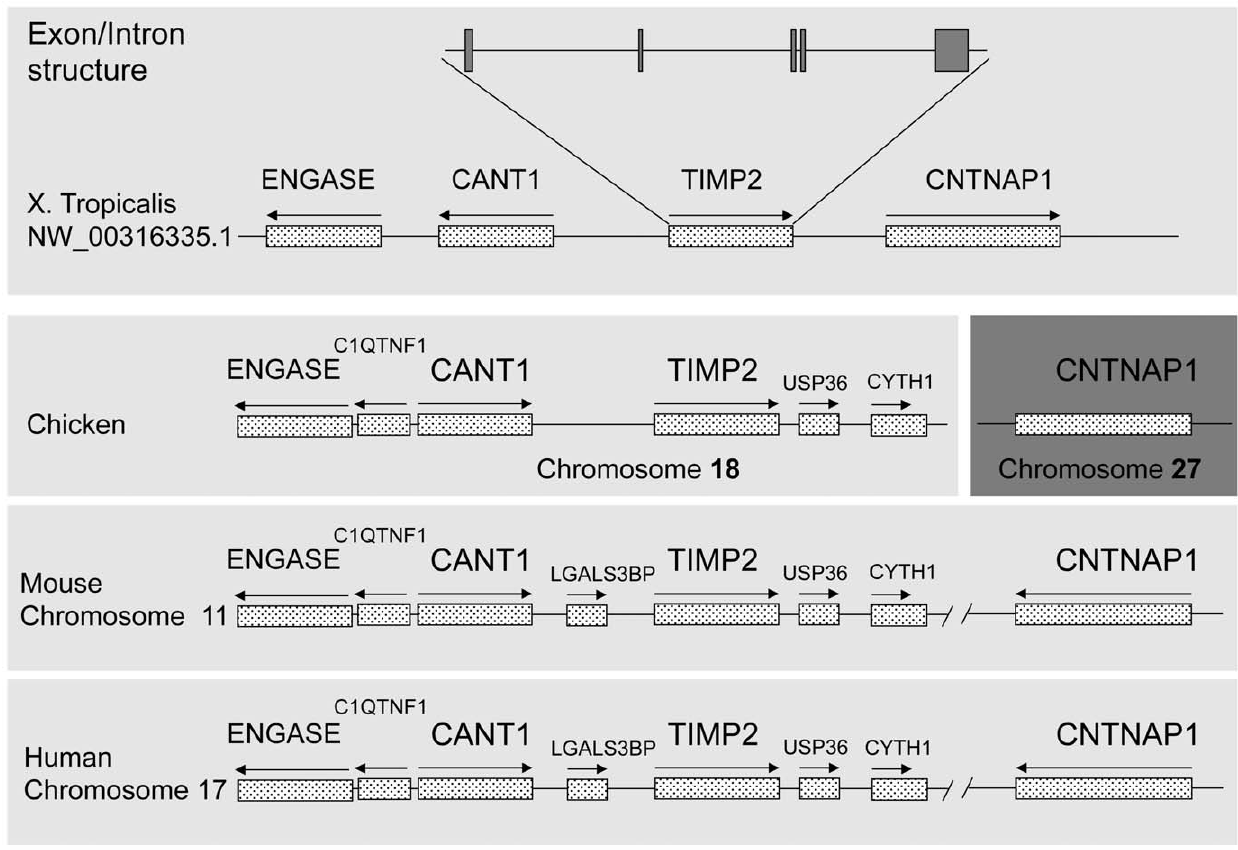
Figure 2. Comparison of the genomic locus and organization of X.tropicalis and human TIMP2. X. tropicalis, chicken, mouse and human TIMP2 genomic organizations were obtained from NCBI database. The lines represent the genomic sequences and the boxes with arrowed lines on top represent transcribed regions and the direction of the transcription. The lines and boxes were not drawn to the same scale for better visualization. The TIMP2 gene in all four species has the same intron/exon organization with 5 exons total as shown for X. tropicalis TIMP2 (not shown). Note that mouse and human TIMP2 loci are identical. In the chicken, CNTNAP1 gene is present on a different chromosome (shown in a darker shade).